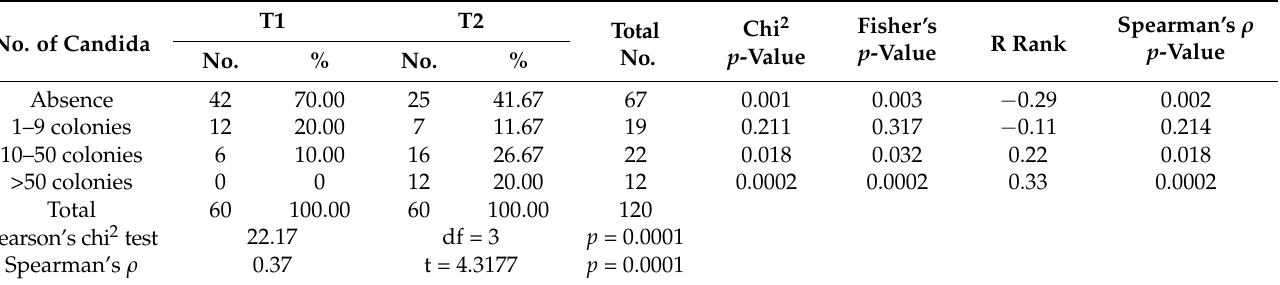
Table 2. Analysis of the relationship between the number of isolated Candida colonies and the time at which the study was